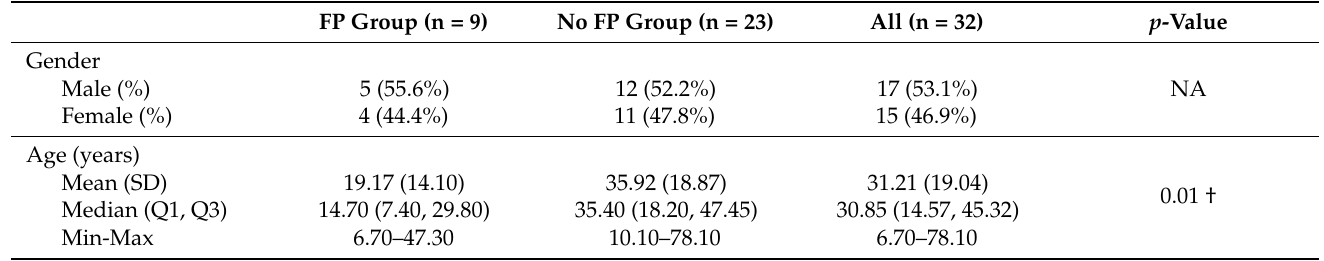
Table 2. Demographic characteristics of patients, according to the appearance of the fovea.